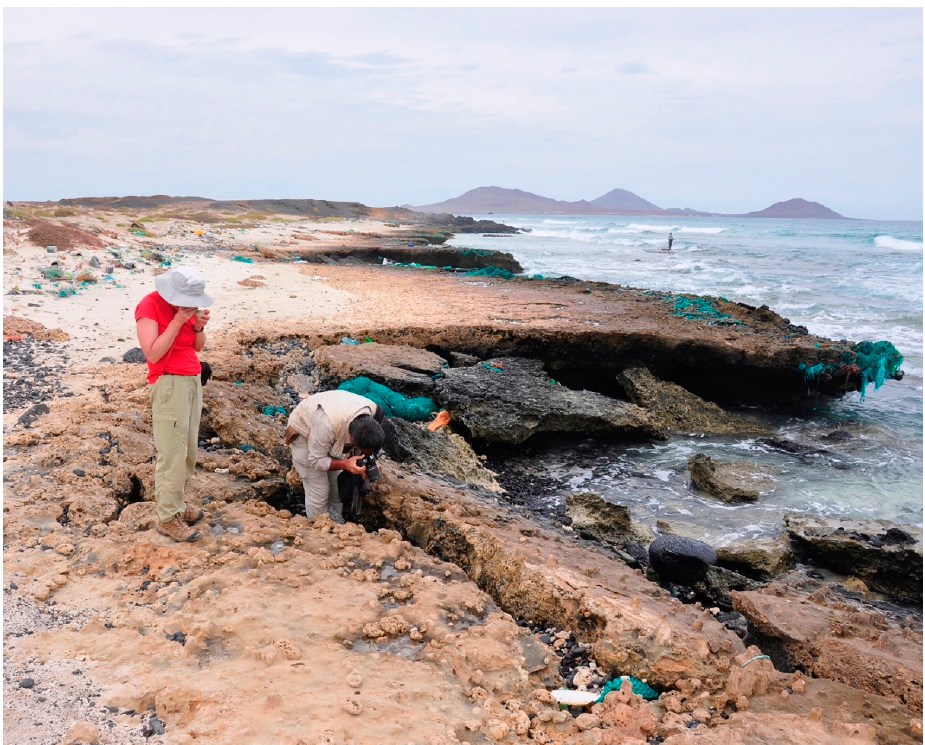
Figure 2. Upper Pleistocene rhodolithic limestone at Baía da Parda on the east coast of Sal Island in the Cabo Verde Archipelago (view to the north). The seaward overhang of protruding sea cliffs is typical along this stretch of the coast. Geosciences 2020 , 10 , x FOR PEER REVIEW